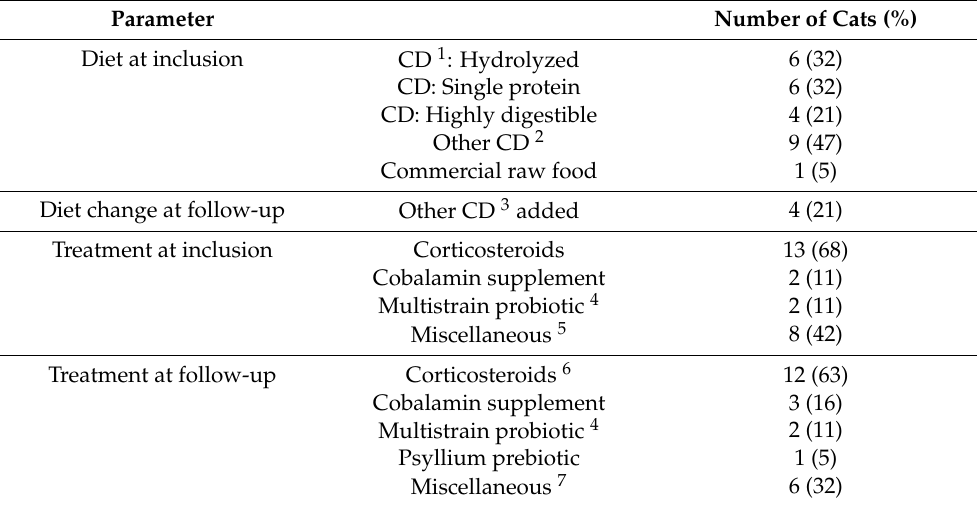
Table 3. Diet and concurrent medical treatments at study inclusion and between inclusion and follow-up in 19 cats with suspected chronic pancreatitis treated with cyclosporine. Most of the cats received more than one diet.